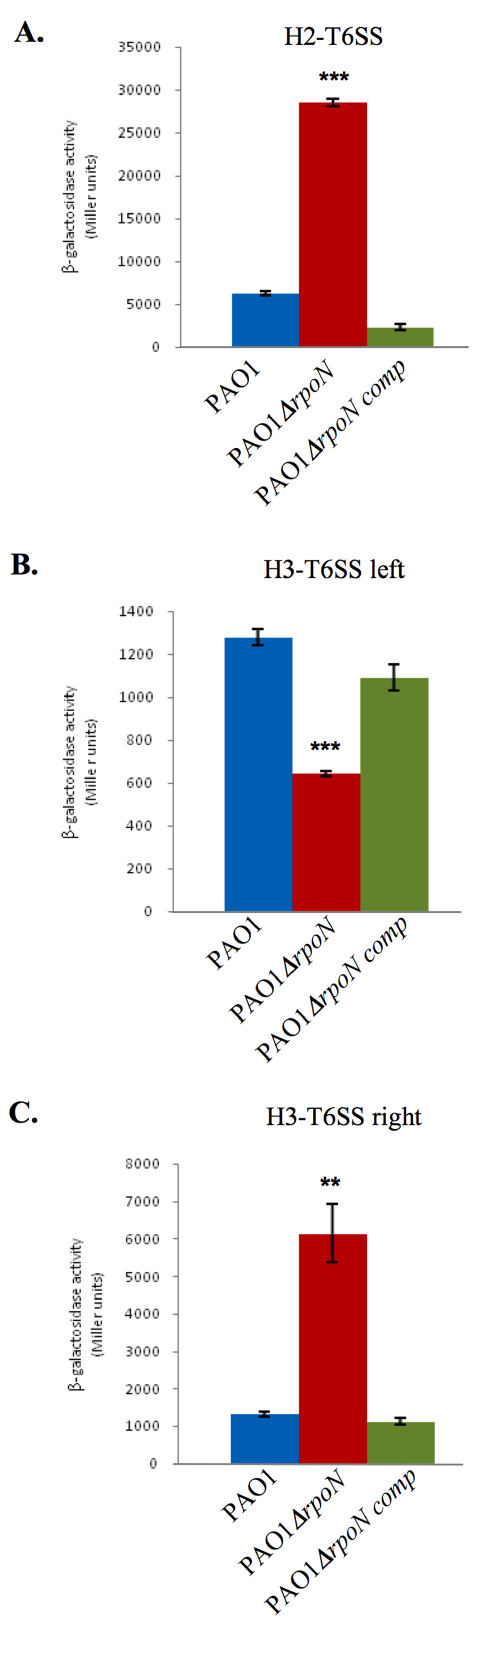
Figure 4. Divergent control of RpoN on H2-T6SS and H3-T6SS . The expression of H2-T6SS (A) , H3-T6SS left (B) , and H3-T6SS right (C) after 7 hours (A) , or 9 hours (B & C) of growth at 37 u C in the WT strain (blue bars), in a PAO1 D rpoN mutant complemented strain (green bars, PAO6360 strain) or the PAO1 D rpoN mutant (red bars, PAO6358 strain). Expression is given in Miller units. Each experiment was done in triplicate and independently repeated three times; error bars indicate the standard